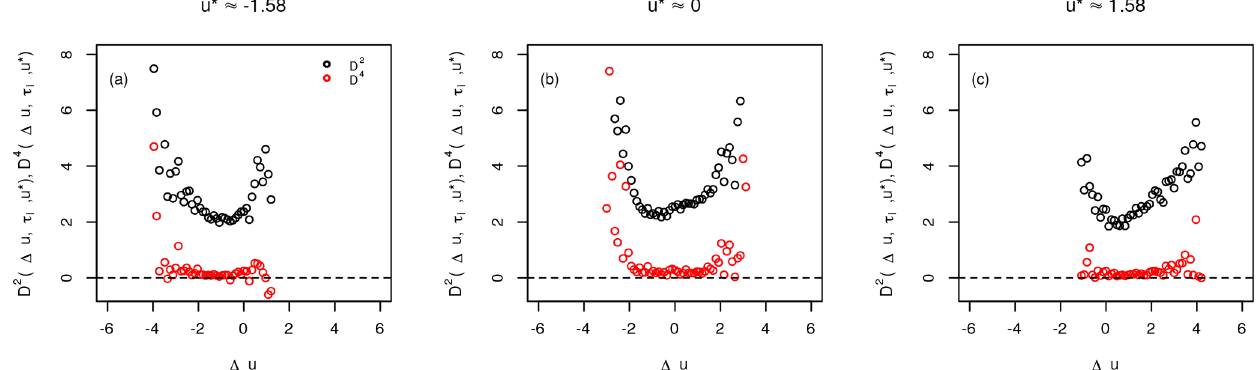
Figure 4. Exemplary estimations of the second and fourth Kramers–Moyal coefficients D (2) ( (cid:49)u,τ i ,u ∗ ) and D (4) ( (cid:49)u,τ i ,u ∗ ) for τ =